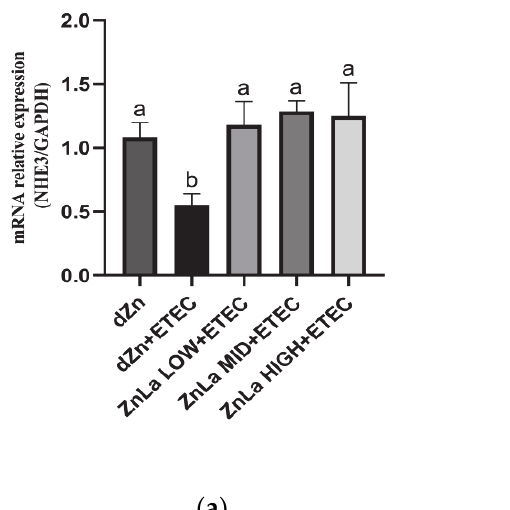
mRNA expression of ( a ) NHE3 and ( b ) CFTR in jejunum. The data are expressed as mean ± s.e.m (n